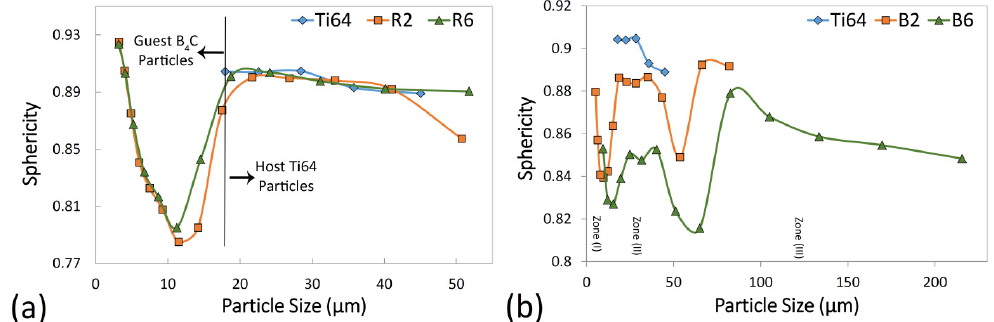
Figure 8. The sphericity of the particles as a function of their size for: ( a ) regularly mixed and ( b ) ball-milled 5 wt.% B 4 C / Ti64 composite powder feedstocks. In each case, the sphericity of the starting Ti-6Al-4V (Ti64) powder is provided as the reference.